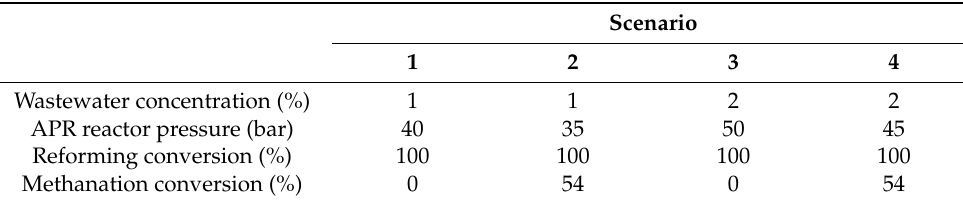
Table 4. Operating conditions for different scenarios considered in heat integration